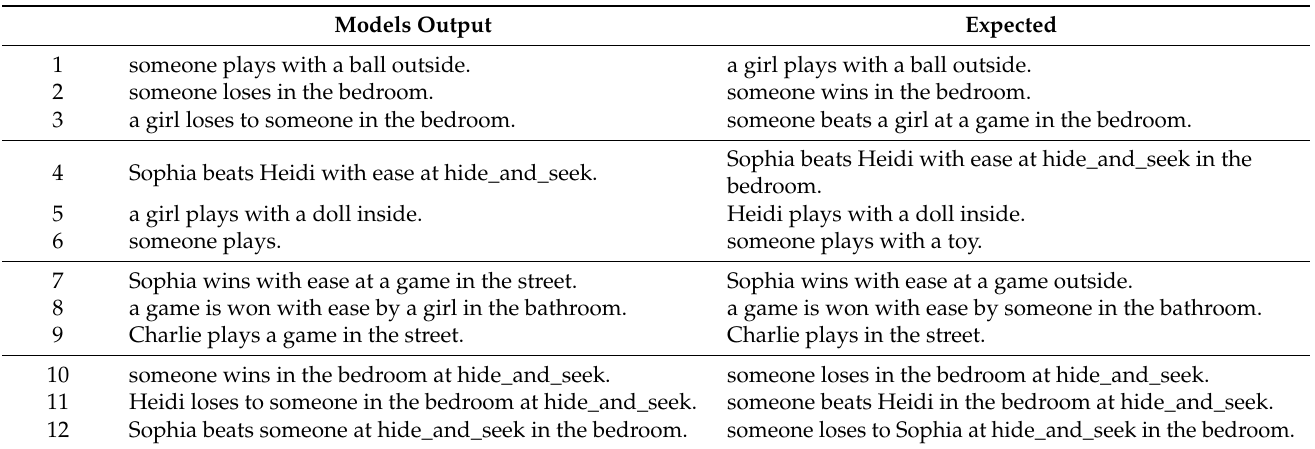
Table 7. Examples of representative output